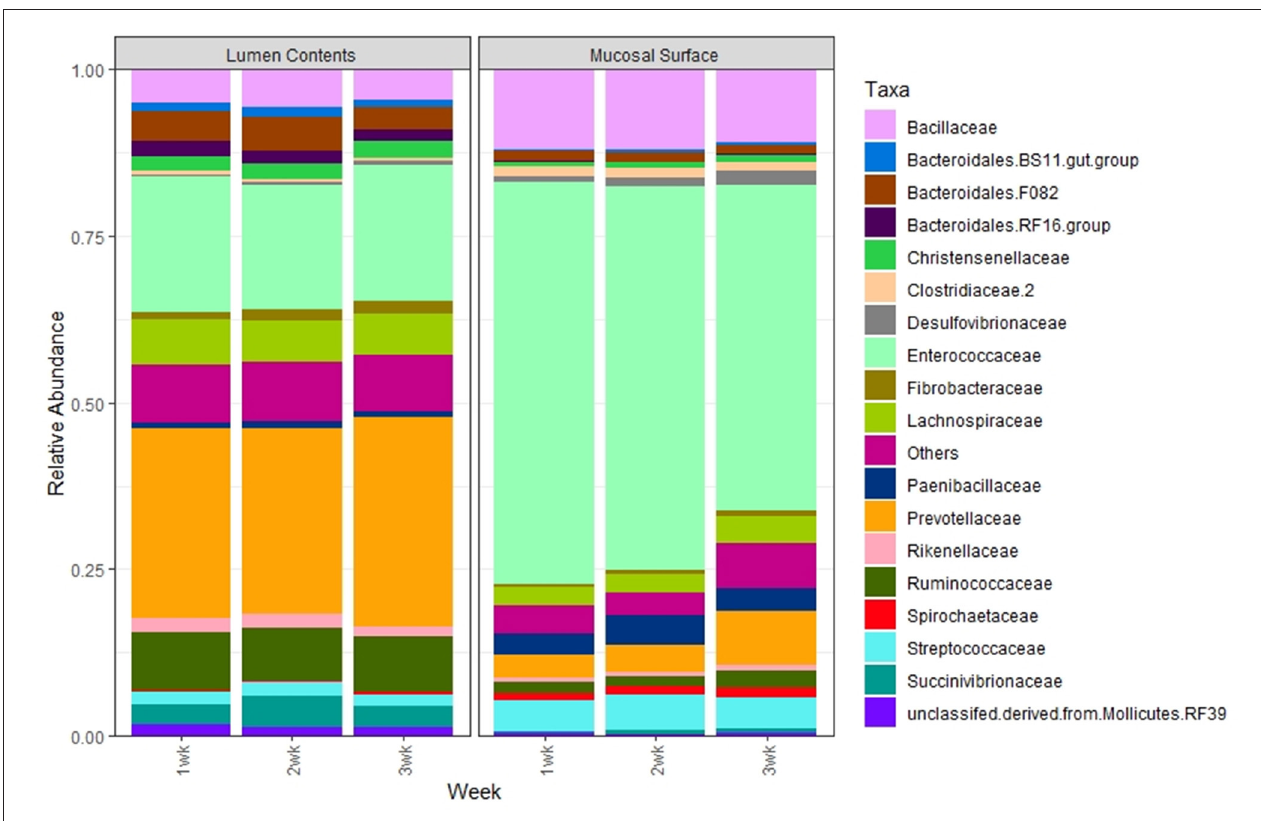
FIGURE 8 | Bacterial family. Stacked bar chart representing the average abundance of the microbiota at the family taxonomic level in the mucosal biopsy surface and lumen contents across the sampled weeks.